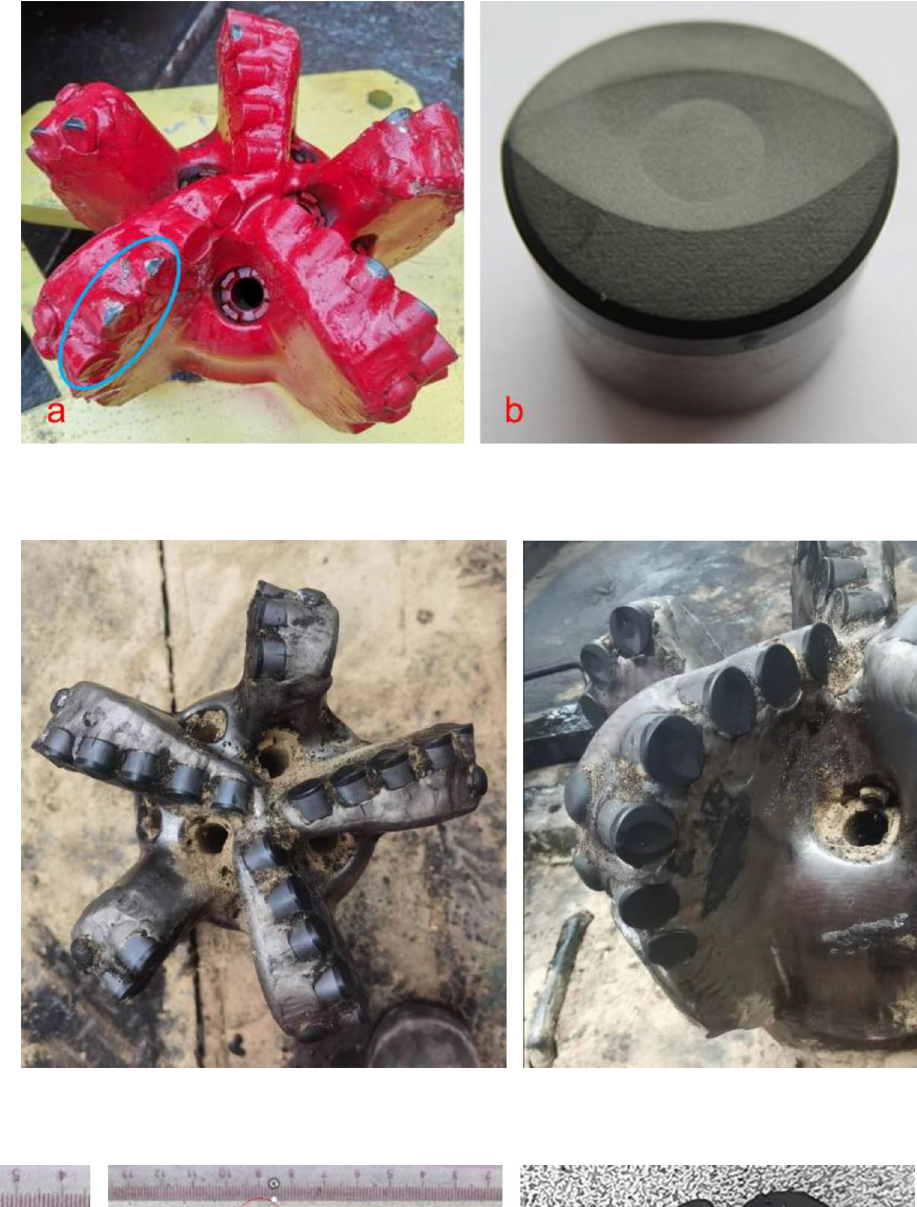
Fig. 22 Flat/3D concave-shaped cutter bit and 3D concave- shaped cutter: a 3D concave- shaped cutter bit; b 3D concave- shaped cutter